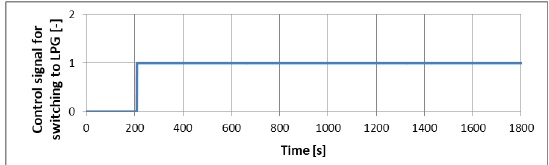
Figure 4: The control signal for switching the power supply to LPG as a function of the WLTC cycle time for the temperature of − 10 ∘ C.